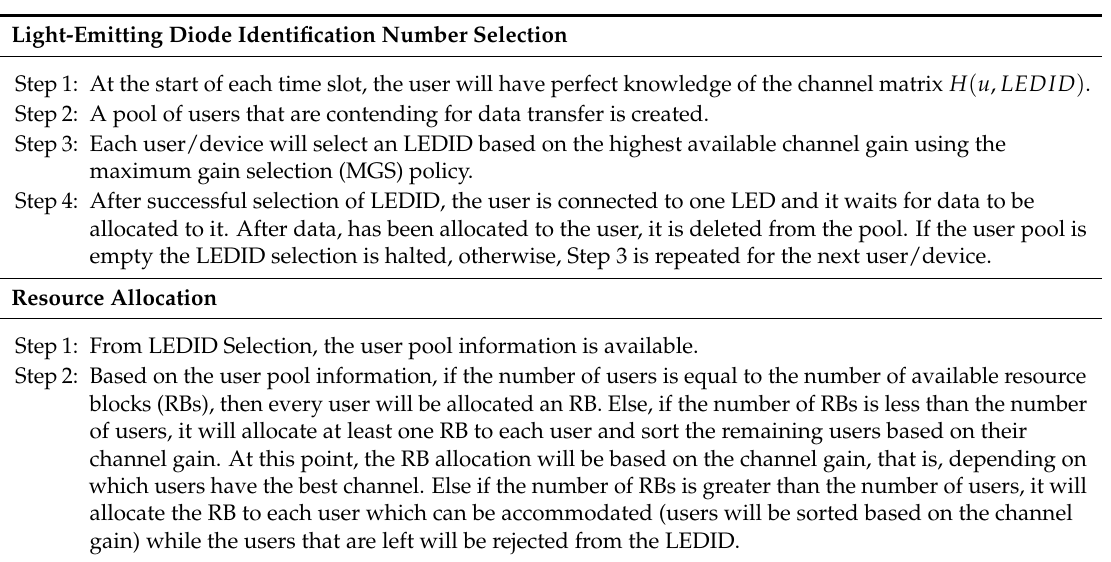
Table 1. Non-cooperative resource allocation